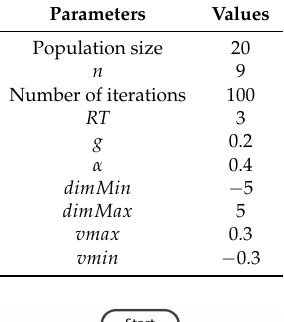
Table 4. Parameters of WDO.